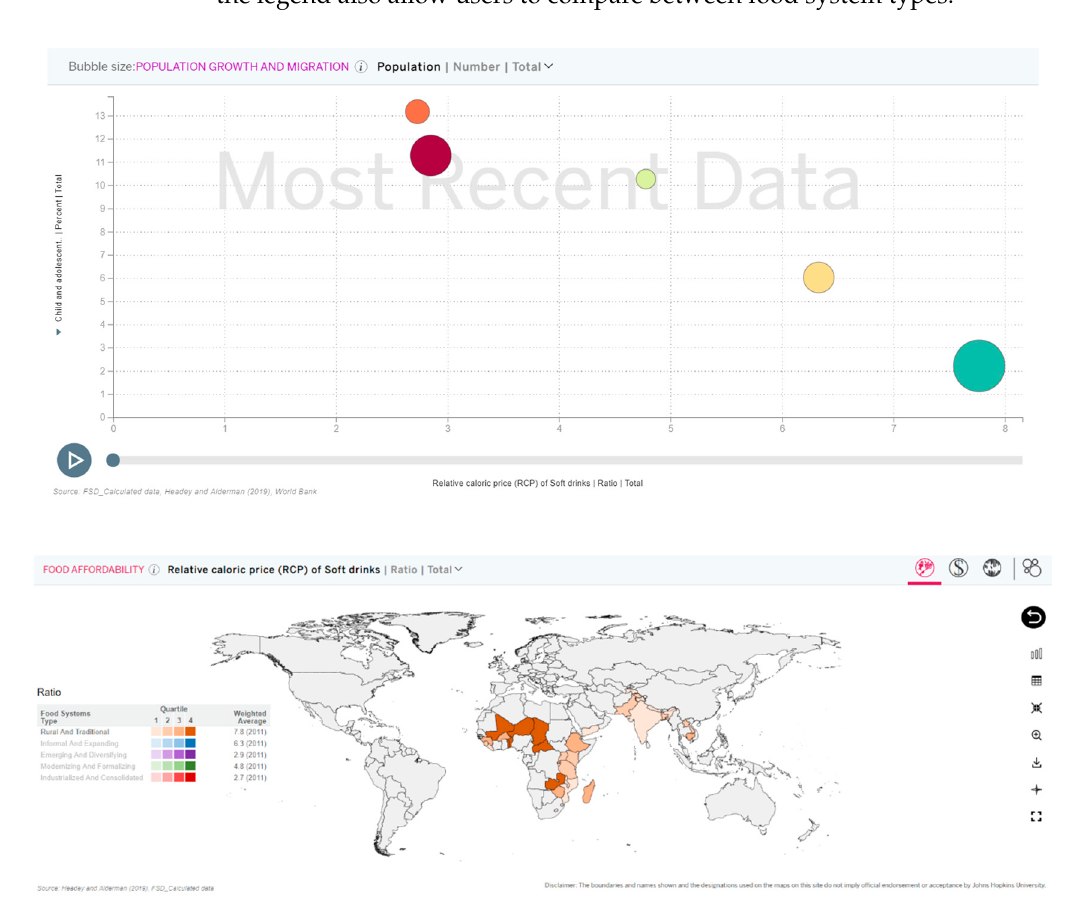
Figure 6. Using the food system typology to compare between and within food system types. Source: (“Food Systems Dashboard” 2020 [51,52]).